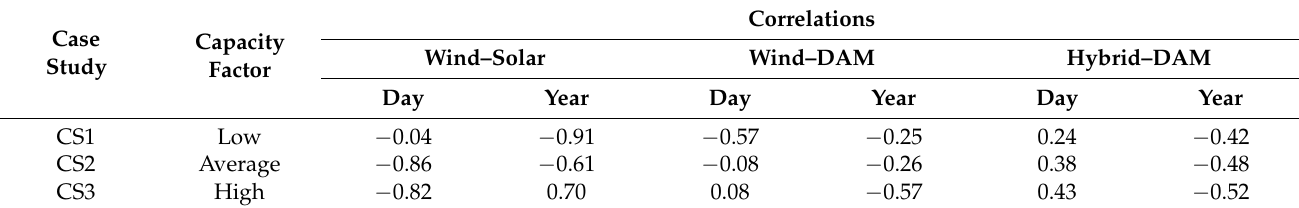
Table 1. Main characteristics of the selected case studies.